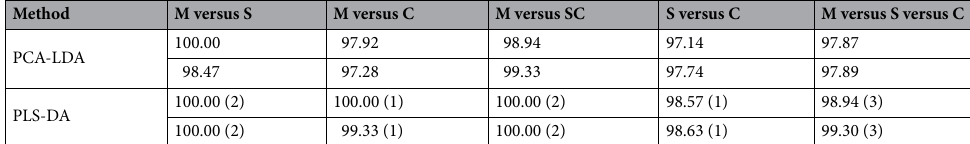
Table 3. Accuracy of classification between groups using the full set of proteins (590 proteins). Accuracy of classification between groups using PCA-LDA or PLS-DA and leave-one-out cross-validation (top value) or repeated k-fold cross-validation (k = 10, times = 3) (bottom value). For PLS-DA, the number in parenthesis lists the number of latent variables